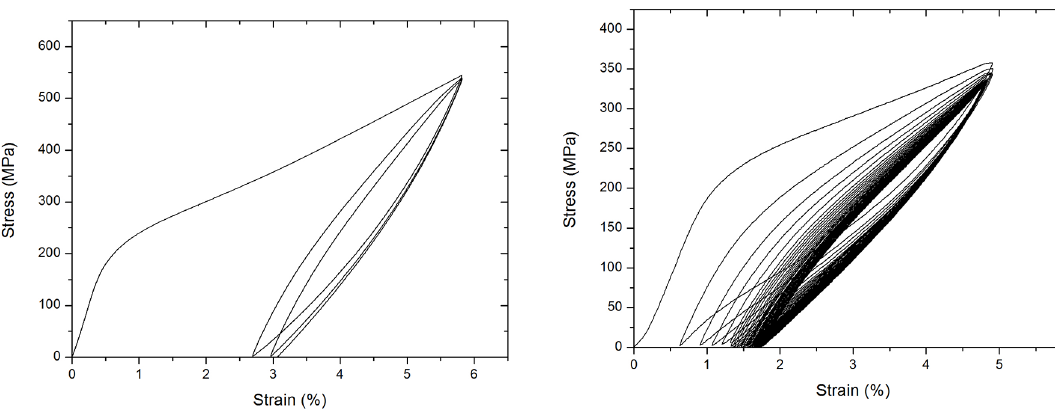
Figure 6. Test for the quantification of the superelasticity at the temperature of 25ºC with 40 cycles of deformation for Cu-11,8Al- 0,6Be-0,5Nb (wt.%) alloy.